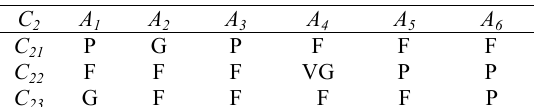
Table 4. Performance assessments of alternatives for Commercial ( C 2 ).